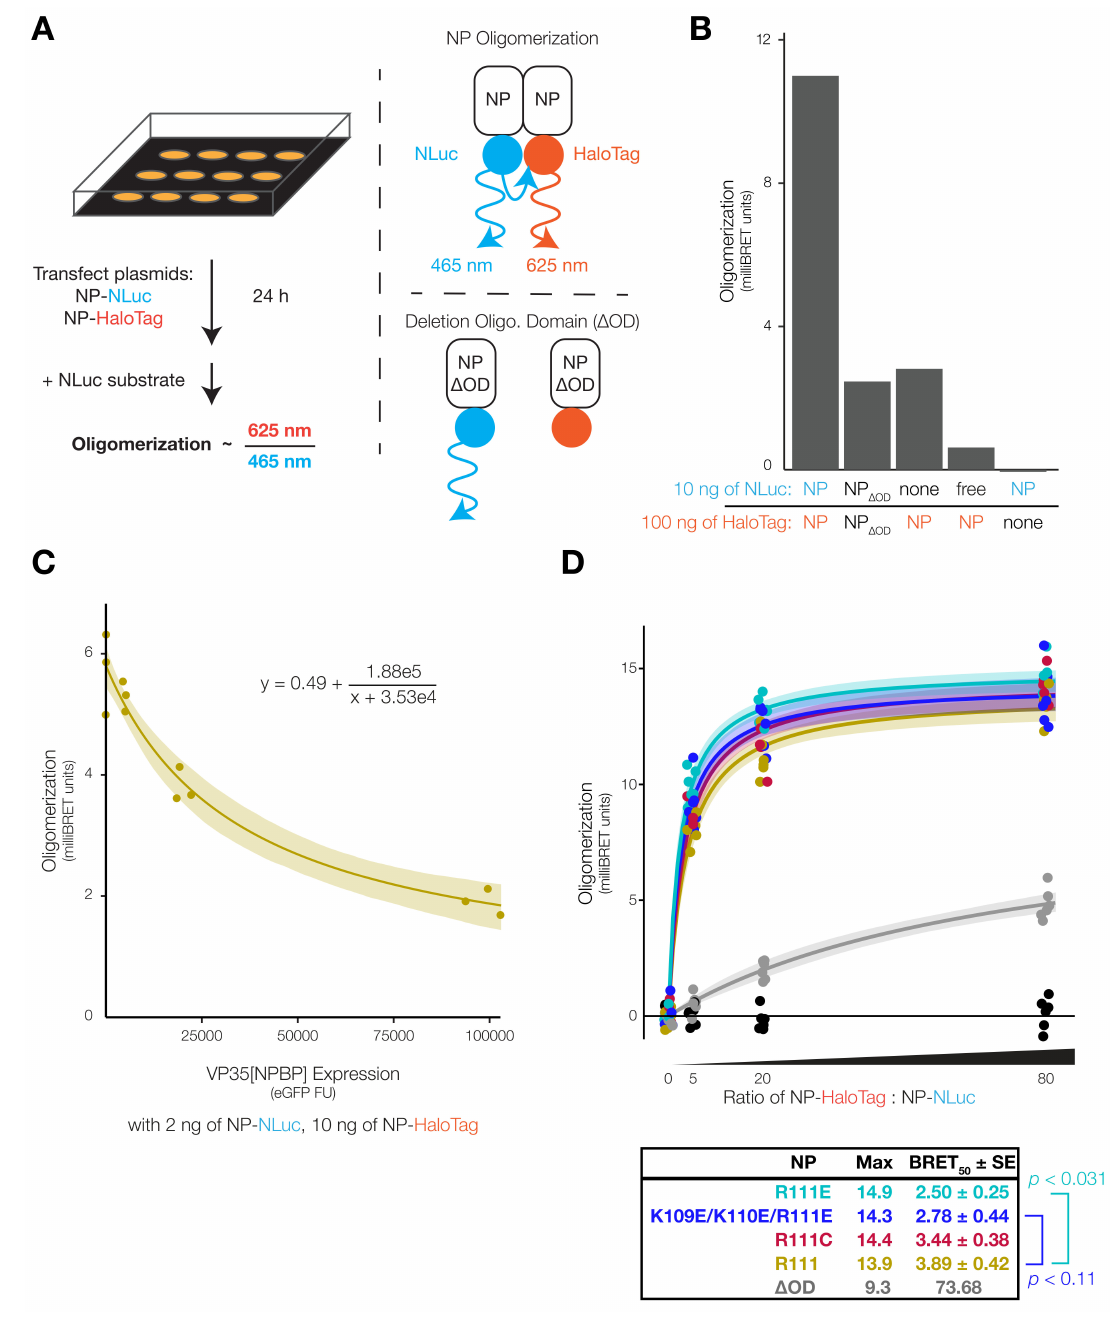
Figure 3. NP position 111 significantly a ff ects oligomerization of NP. ( A ) Schematic of the NP oligomerization assay. We co-expressed NP fused to NanoLuc (NLuc, donor) and HaloTag (acceptor) in HEK 293FT cells. NP–NP binding and oligomerization brought the tags into close spatial proximity, producing bioluminescence resonance energy transfer (BRET) emission at 625 nm. To calculate BRET signal in milliBRET units, we normalized 625 nm BRET luminescence against NP-NLuc luminescence at 465 nm and subtracted spectral spillover from NP-NLuc into the 625 nm channel; ( B ) BRET oligomerization assay controls. Absence of either tag, free NLuc (not fused to NP), or deletion of the NP oligomerization domain ( ∆ OD, residues 20–38) reduced BRET signal; ( C ) EBOV VP35 NP-binding peptide (NPBP) disrupted NP oligomerization. In addition to NP-NLuc and NP-HaloTag, we co-expressed varying amounts of VP35[NPBP] in cells. To quantify VP35[NPBP] expression,